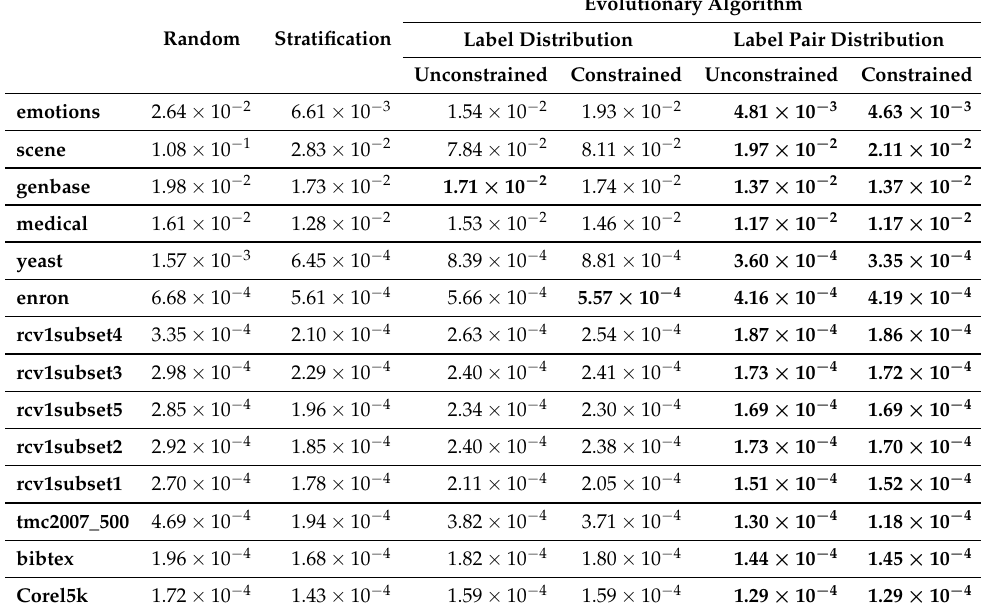
Table 4. Label Pair Distribution of different splitting algorithms. In bold the results that are better than the stratification method. In all cases, the evolutionary algorithm that uses LPD as fitness function obtains the best results. This does not happen when the LD is used as fitness